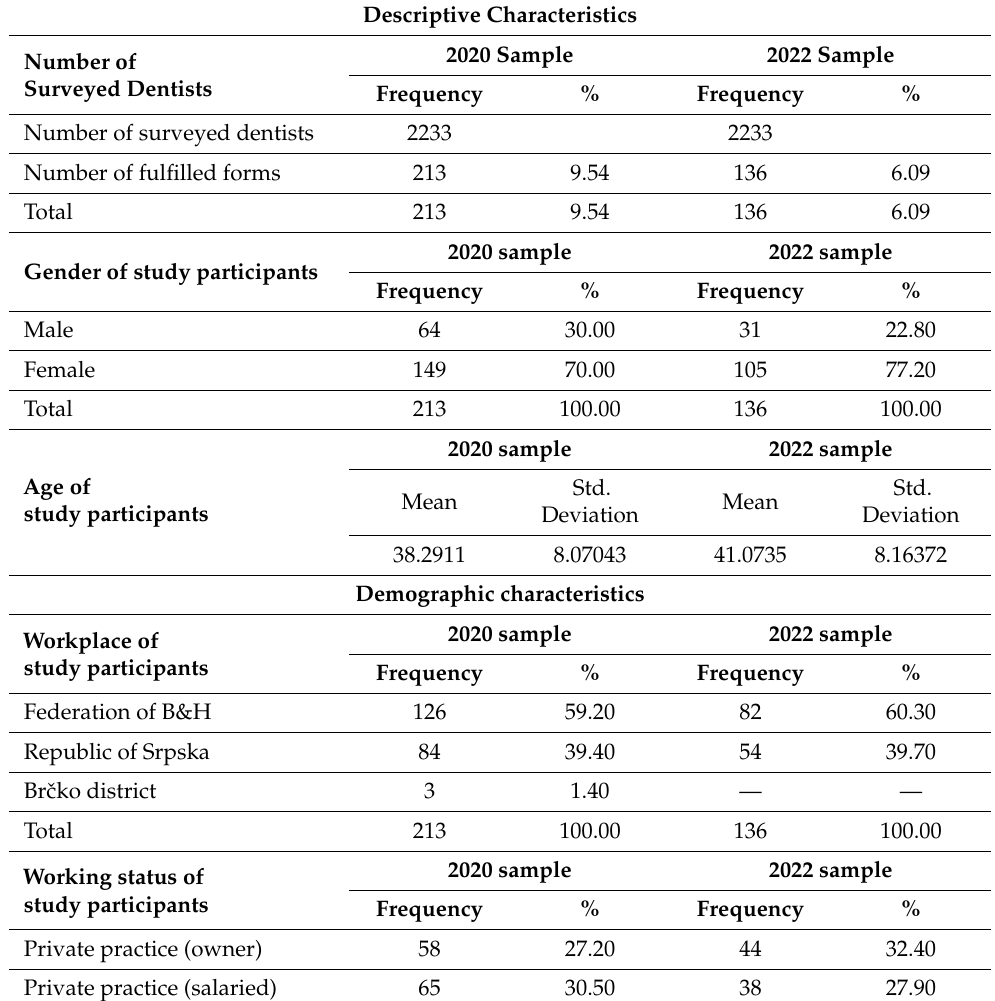
Table 1. Descriptive and demographic characteristics of the study sample. Descriptive